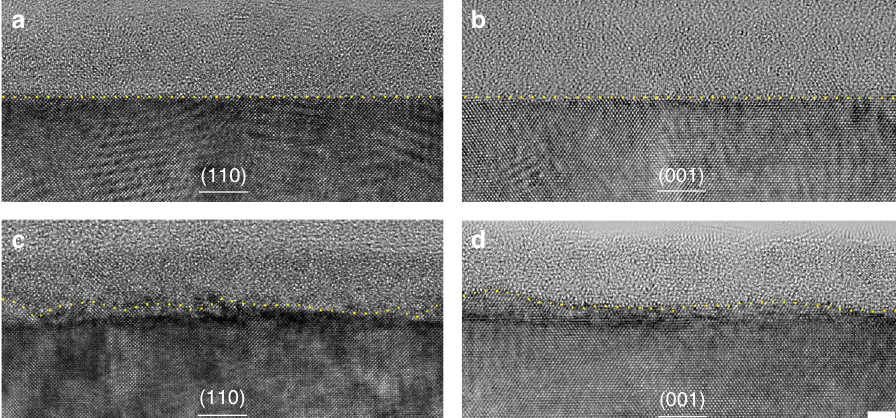
Fig. 3 Chloride-induced undulations at the metal/passive fi lm interface, wherein the yellow line indicates the metal/passive fi lm interface. Scale bar, 2 nm. a , b HRTEM images along the [001] and [110] axes of the austenitic matrix showing the passive fi lm grown on (110) and (001) planes of FeCr 15 Ni 15 single crystal in 0.5 mol L − 1 H 2 SO 4 electrolyte, revealing a sharp and straight interface, even at the atomic scale. c HRTEM images along [001] axis showing the passive fi lm grown on (110) plane in 0.3 mol L − 1 NaCl + 0.5 mol L − 1 H 2 SO 4 electrolyte, revealing an indistinct and substantially undulating interface. d HRTEM images along [110] axis showing the passive fi lm initially grown in 0.5 mol L − 1 H 2 SO 4 electrolyte for 30 min with subsequent addition of NaCl into the H 2 SO 4 electrolyte. The interface is as well indistinct and substantially